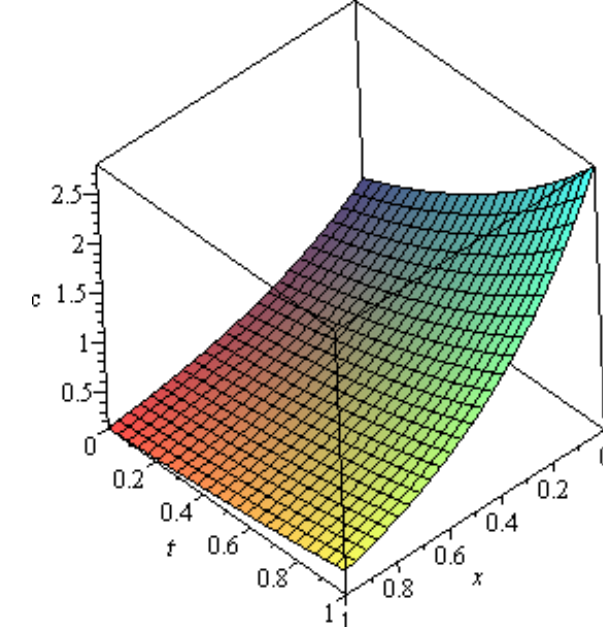
Fig. 7: q -FHATM solution c ( x , t ) verses x and time t at k = 0.03 for